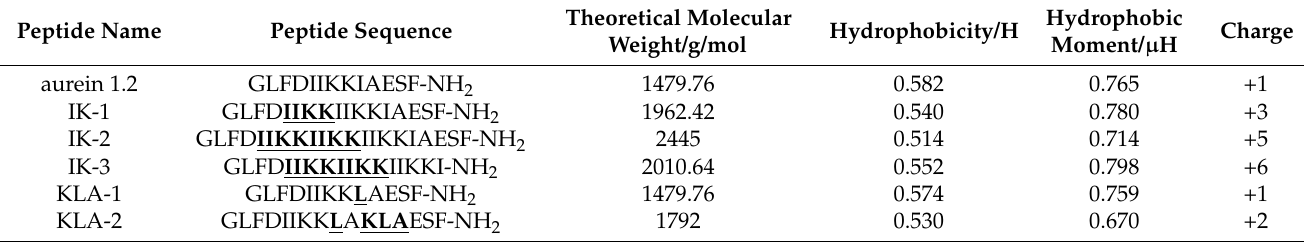
Table 1. Peptide sequences and their physiochemical parameters. The bold and underlined letters indicate the inserted amino acids in the parent peptide